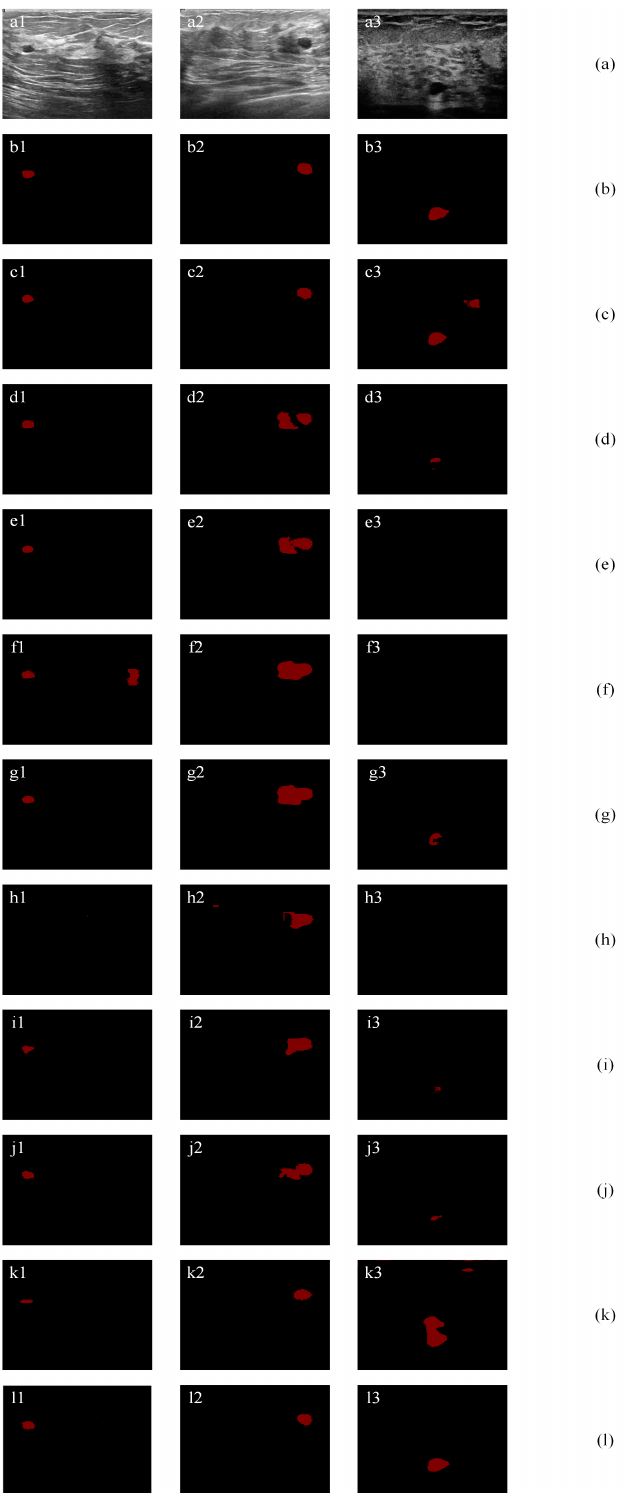
Figure 13. Small tumor segmentation: ( a ) original images; ( b ) ground truths; ( c ) results of ResNet-101 with self-attention mechanism; ( d ) results of a SE-Net (ResNet-101); ( e ) results of attention U-Net; ( f ) results of ResNet-50; ( g ) results of ResNet-101; ( h ) results of Deeplab; ( i ) results of PSPNet; ( j ) results of U-Net with wavelet transform; and ( k ) results of FCN-8s; ( l ) results of proposed